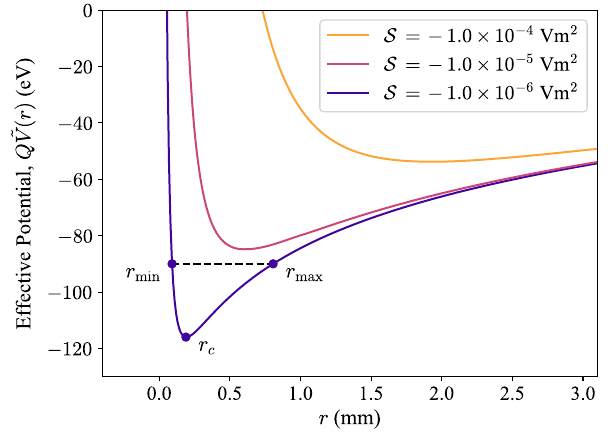
FIG. 6. Effective potential as a function of r with to be the horizontal distance between the beam and the beam screen. r is shown for a given S and r c given E